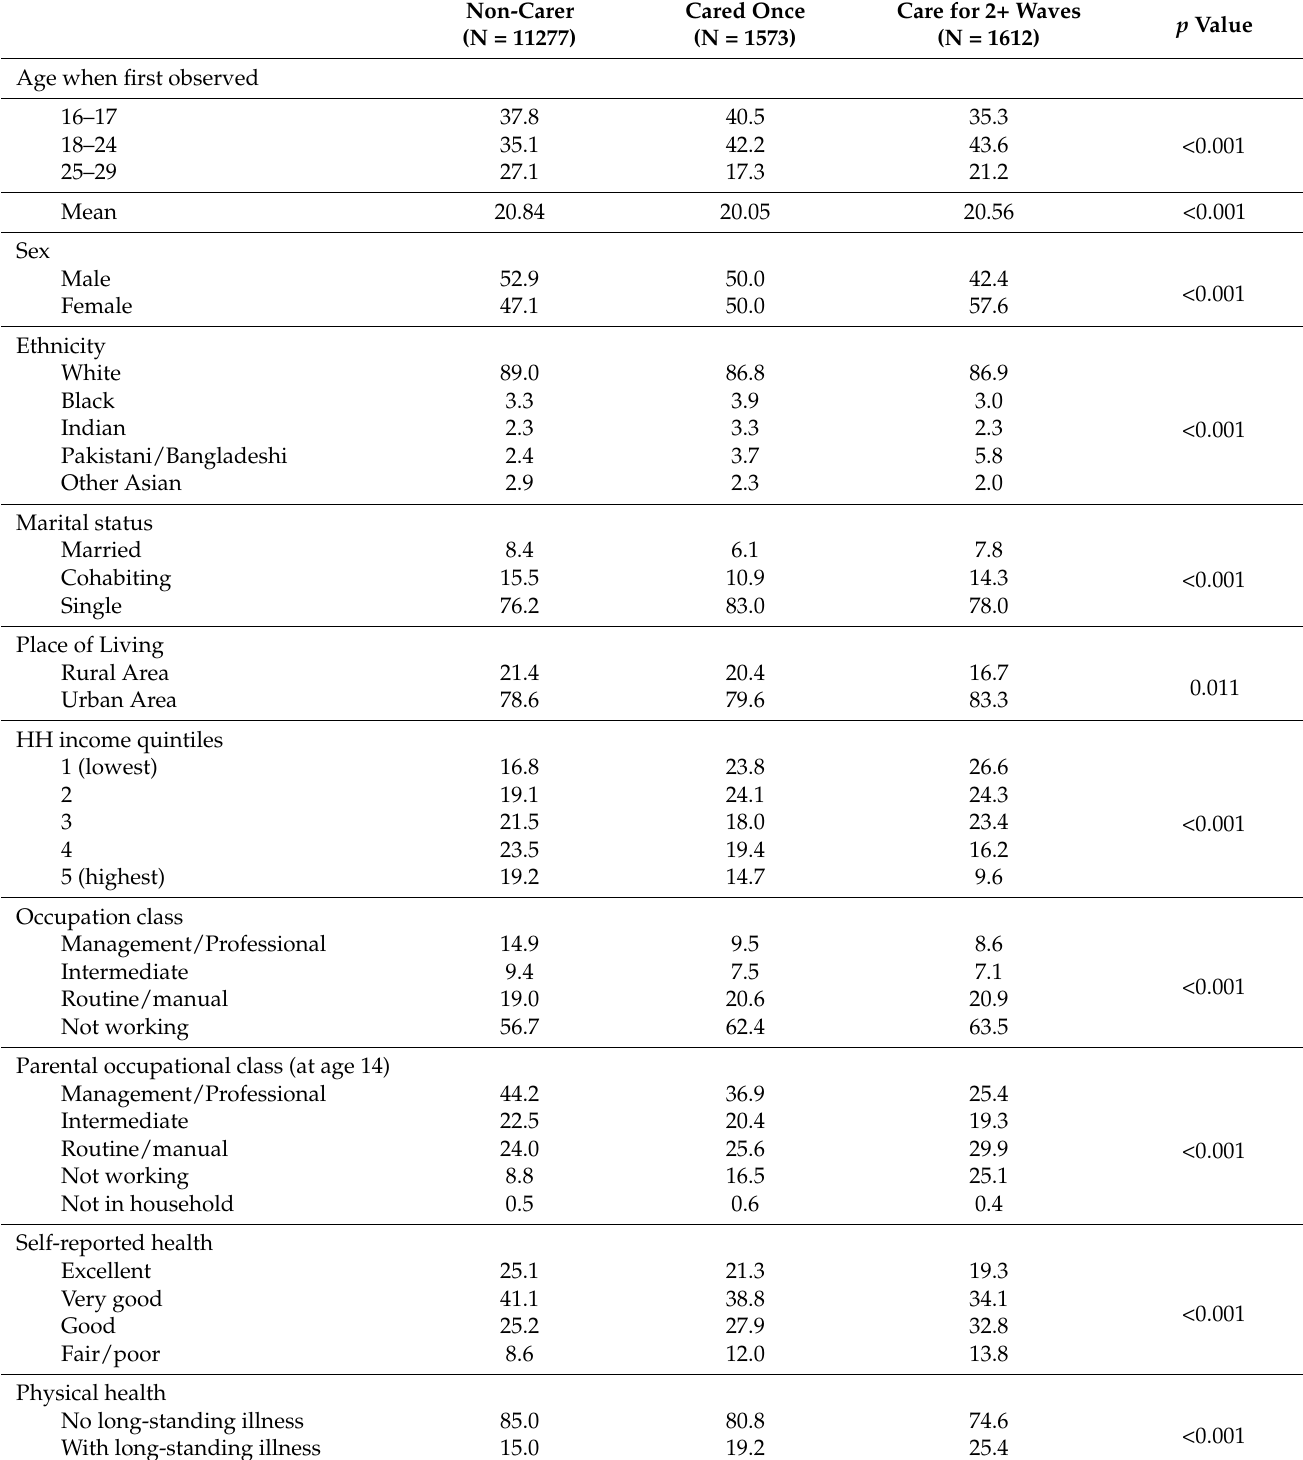
Table 1. Percentage distribution of demographic, socioeconomic, and health characteristics by duration of